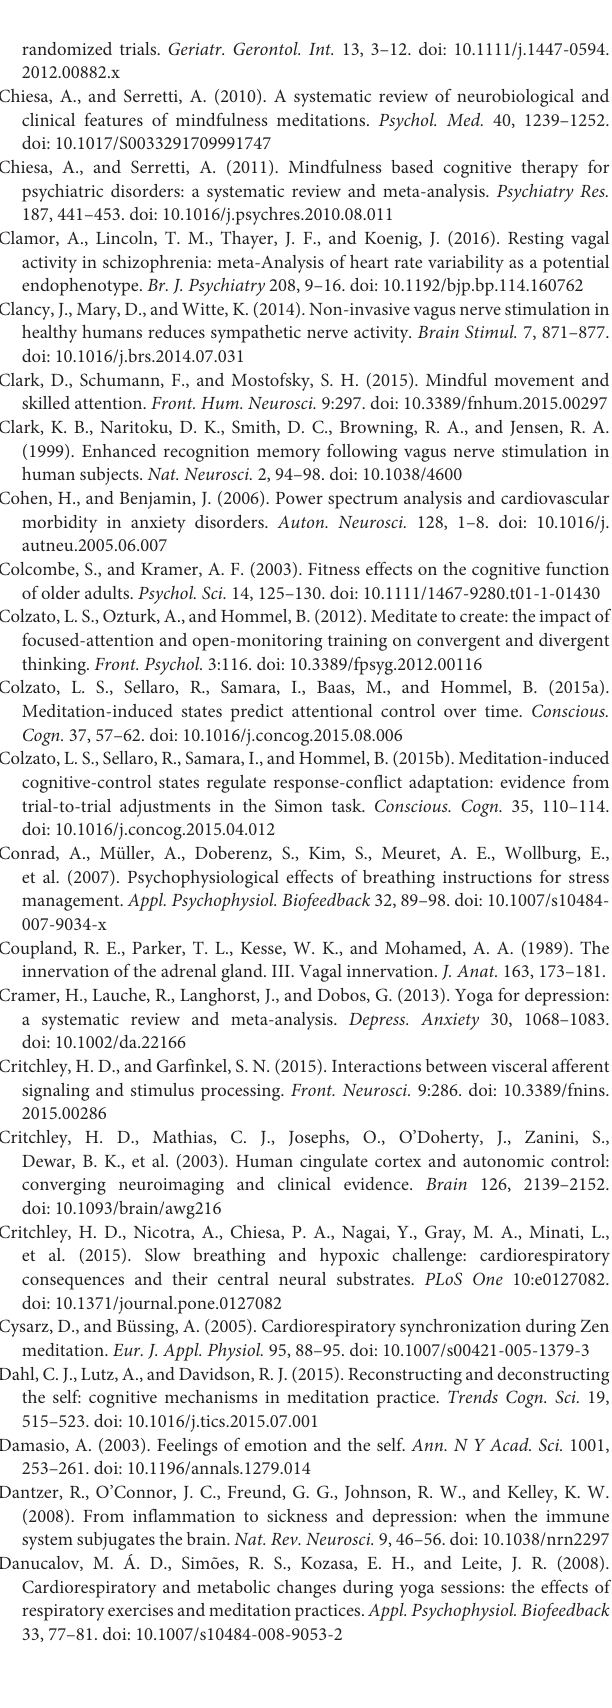
Frontiers in Human Neuroscience |